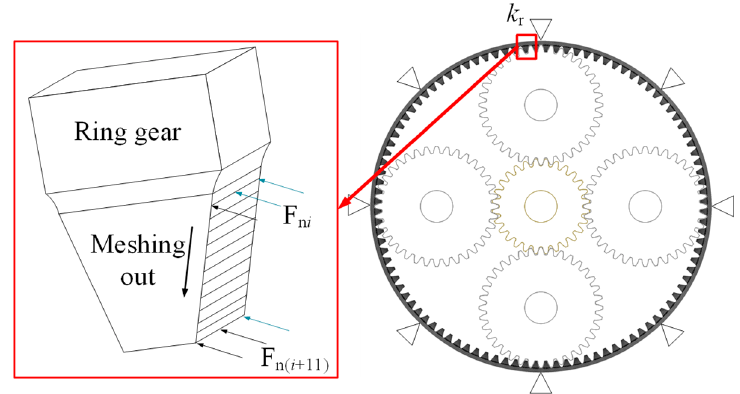
Figure 10. Finite element model and schematic diagram of dynamic load application.